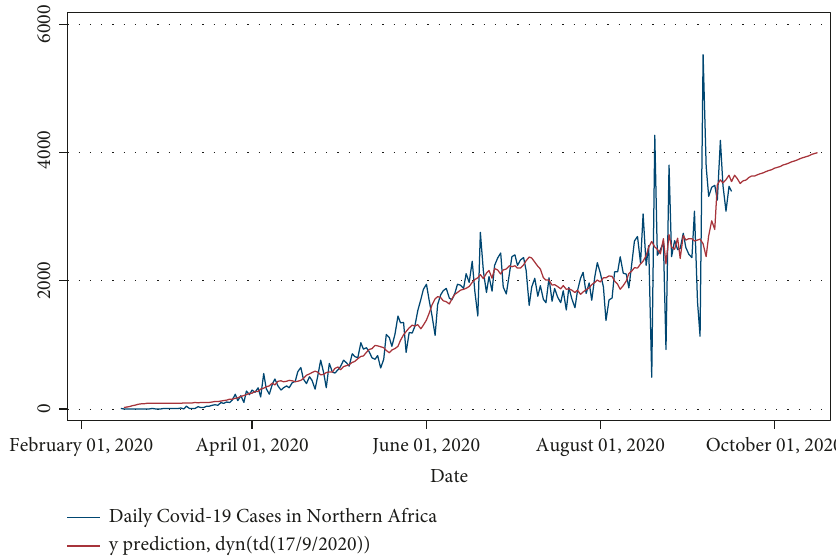
Figure 4: The plot of actual confirmed cases with the prediction results of the ARIMA model for North Africa.